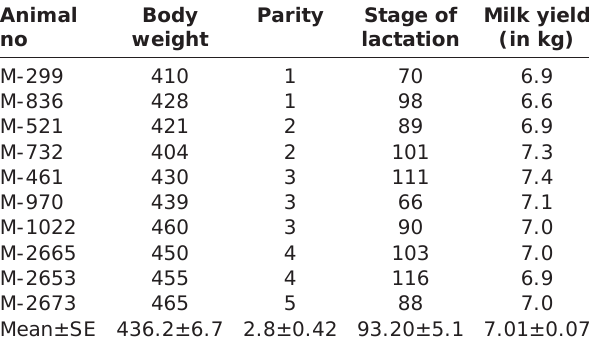
Table-3: Details of experimental buffaloes: Group III